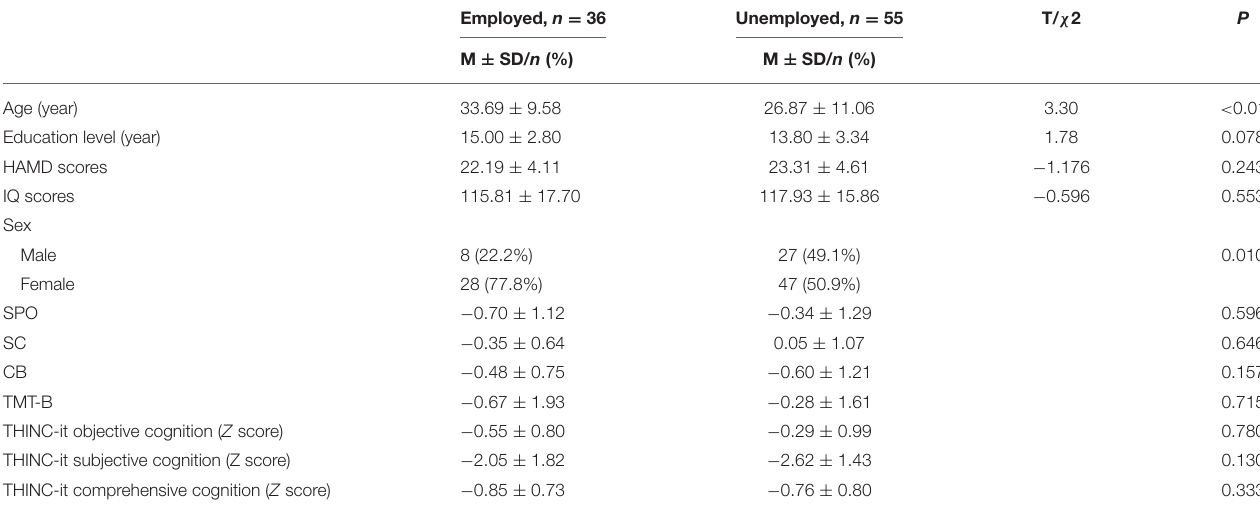
TABLE 4 | General information between employed and unemployed in